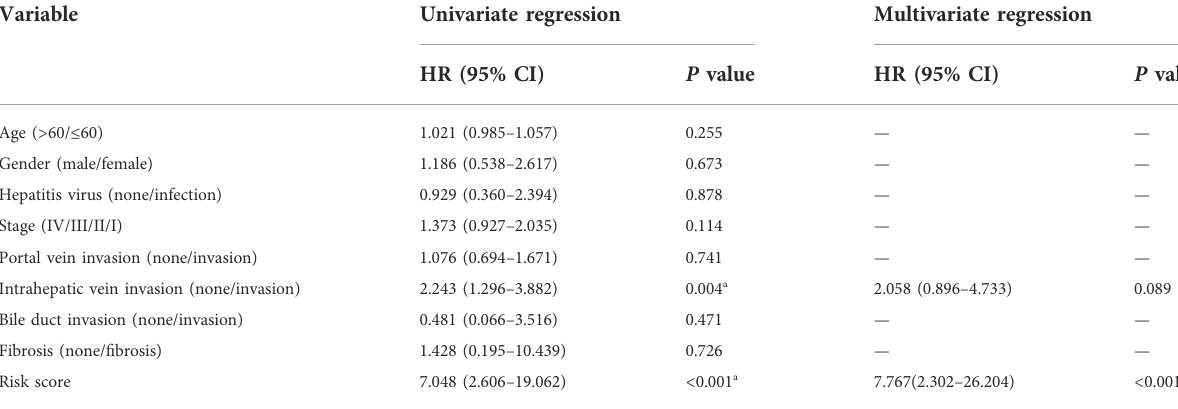
TABLE 2 Univariate and multivariate regression on OS-related clinicopathological features for ICGC-derived HCC cases. Variable